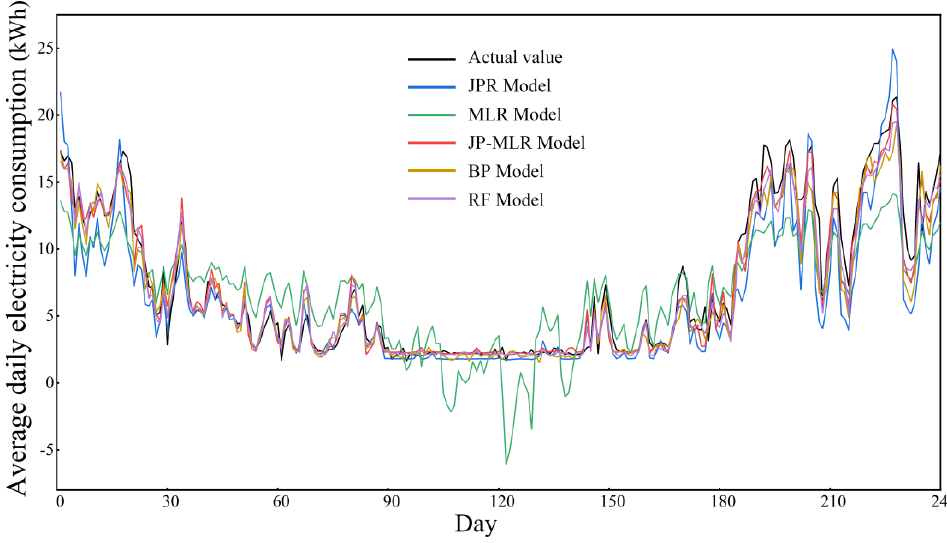
Figure 11. Electricity consumption estimation using 5 models. Table 7. Comparison of evaluation metrics for 4